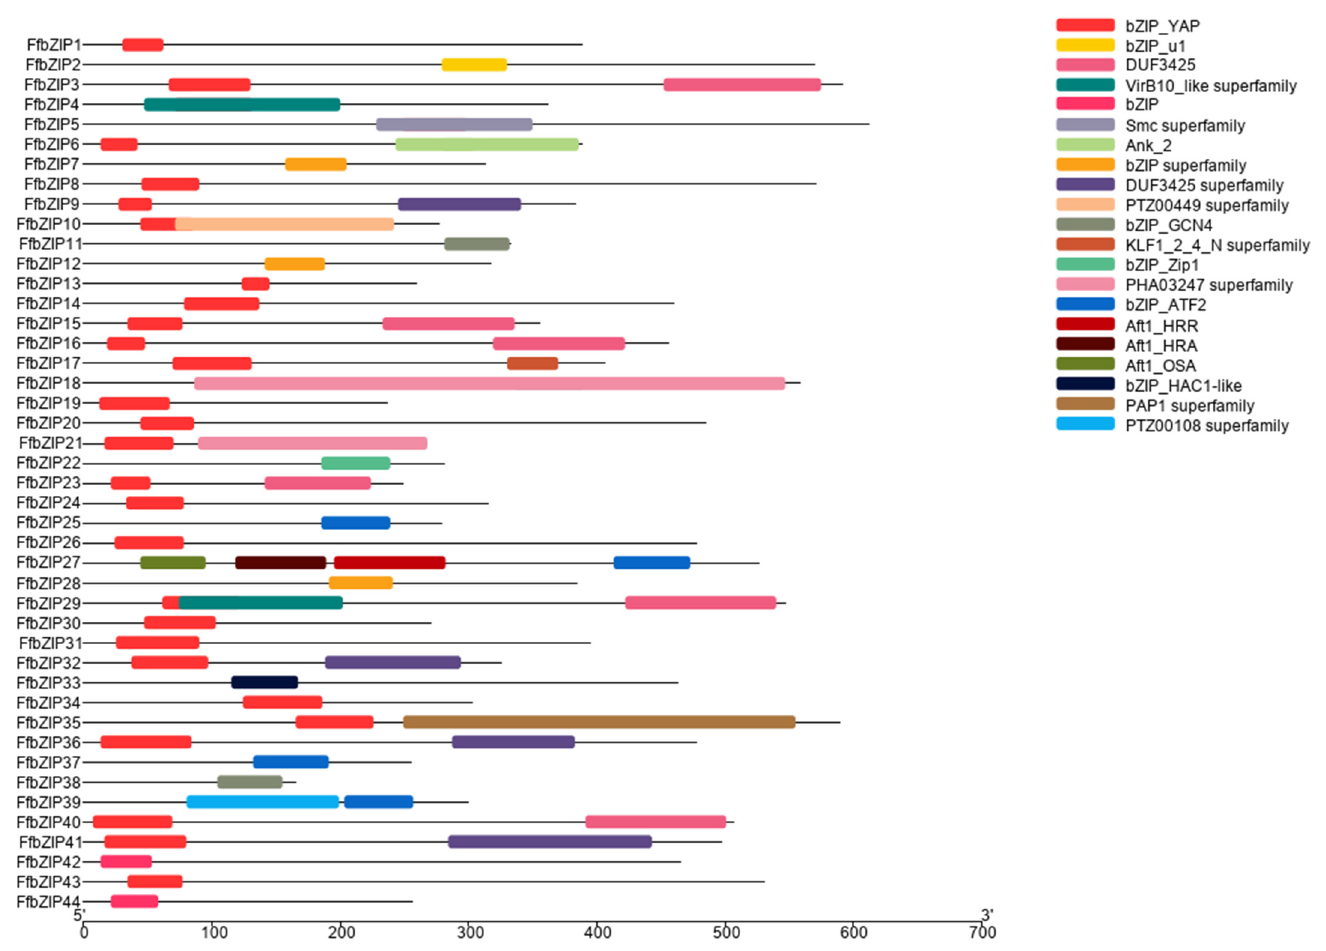
Figure 1. Schematic diagram of the conserved domains of FfbZIP proteins. The N-terminal basic amino acid region of the bZIP domain was highly conserved, containing a nuclear localization signal (NLS) [20] and an N-x7-R/K domain